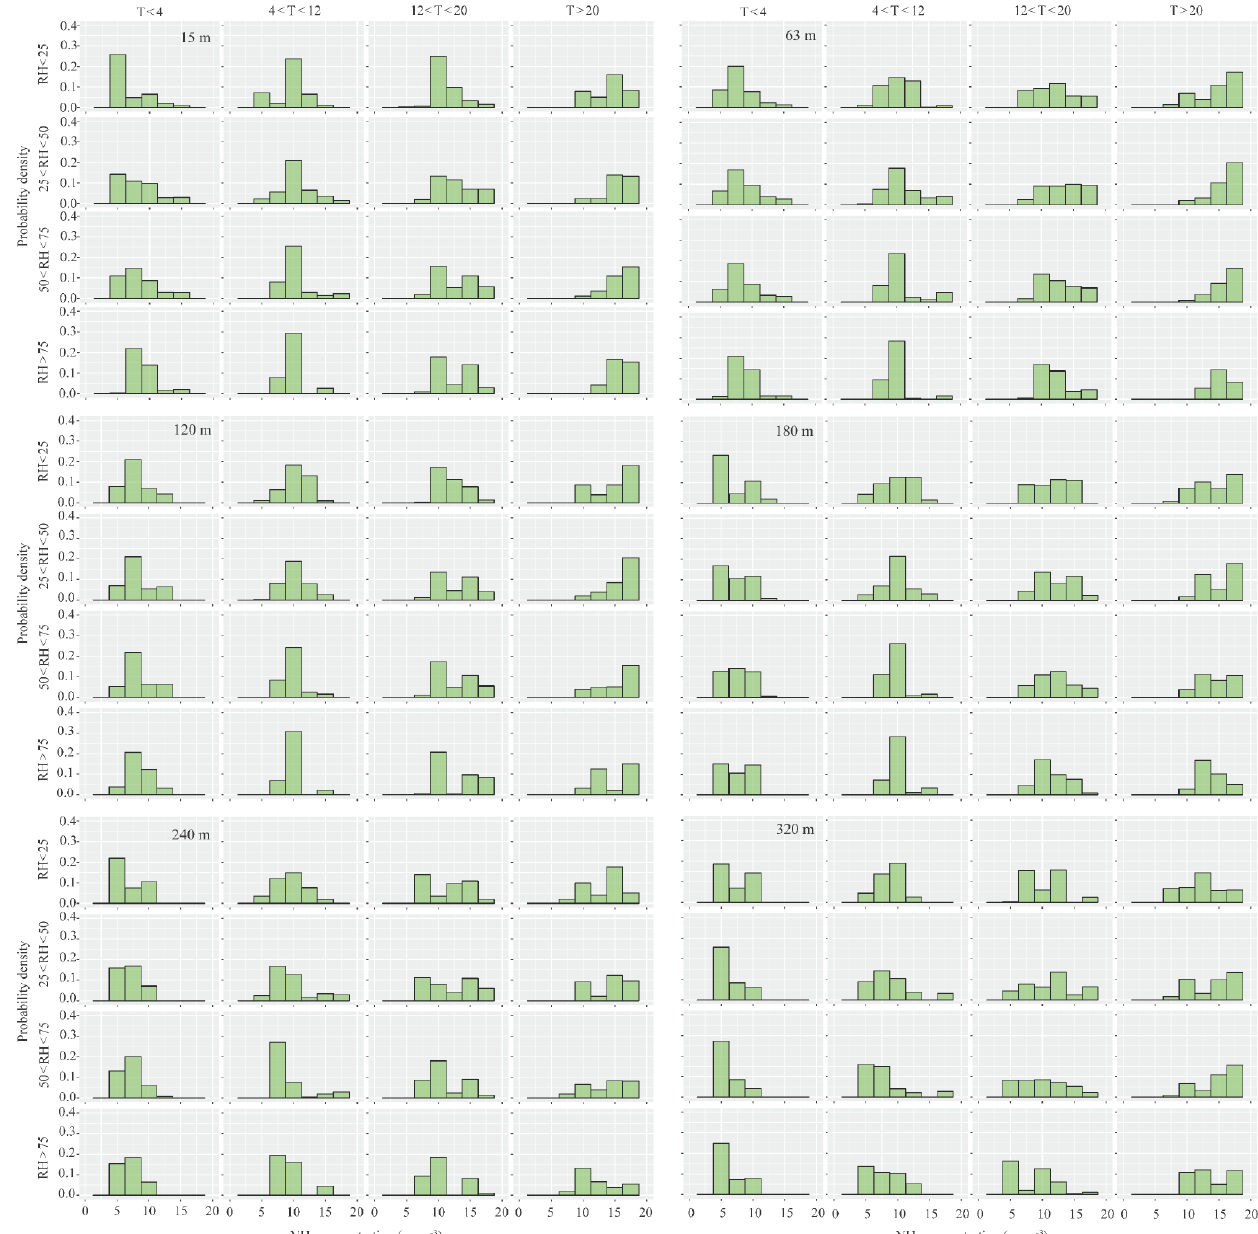
Figure 5. Probability density of NH 3 concentrations (µgm − 3 ) at different ranges of temperature 1 ( ◦ C) and relative humidity 2 (%) for 14 heights. 1 Temperature includes four subsets: < 4, 4–12, 12–20 and > 20 ◦ C; 2 relative humidity includes four subsets: < 25%, 25–50%, 50–75% and >